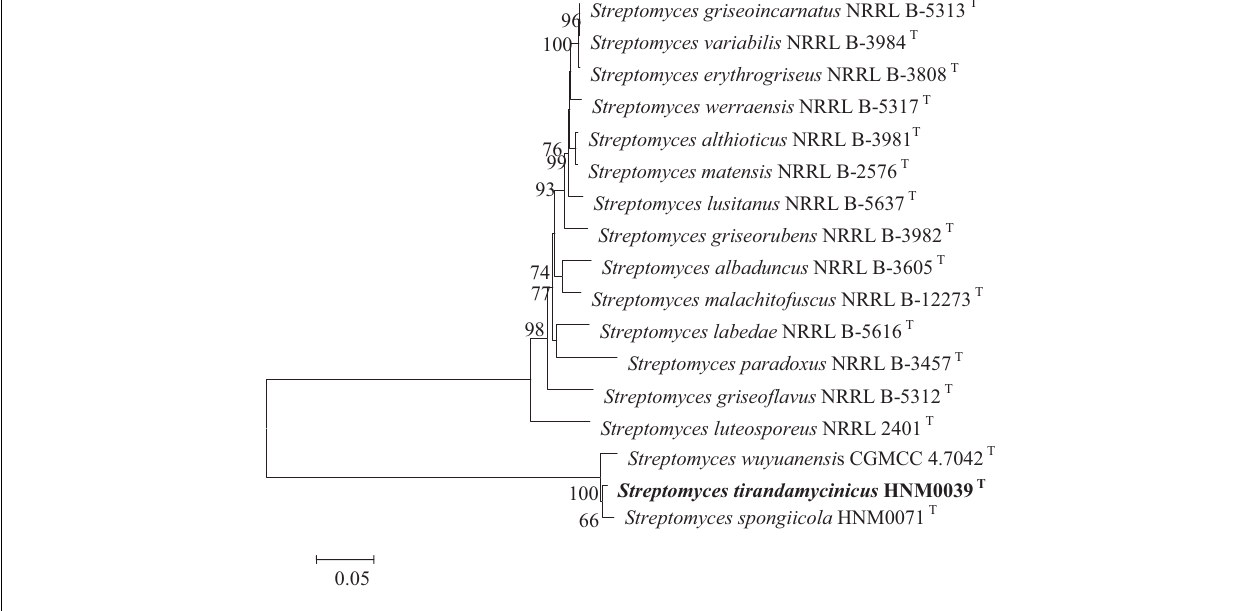
FIGURE 2 | Neighbor-Joining tree based on concatenated five house-keeping genes (atpD, gyrB, rpoB, recA, and trpB) showing the position of strain HNM0039 T amongst its phylogenetic neighbors. Percentages at the nodes represent levels of bootstrap support from 1000 replications datasets. Only values > 50% are given. Bar: 0.05 substitutions per nucleotide